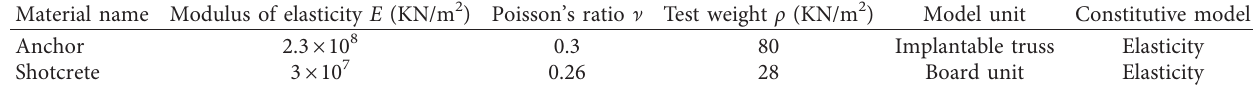
Table 8: Relevant parameters of initial support structure.